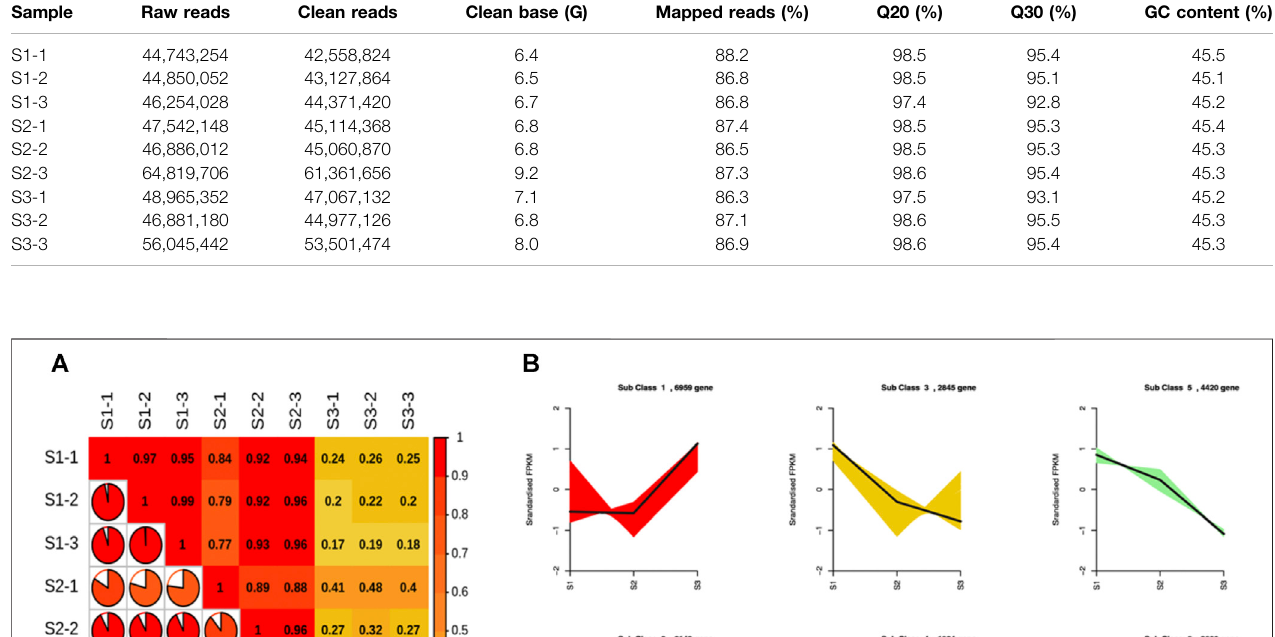
Frontiers in Genetics |